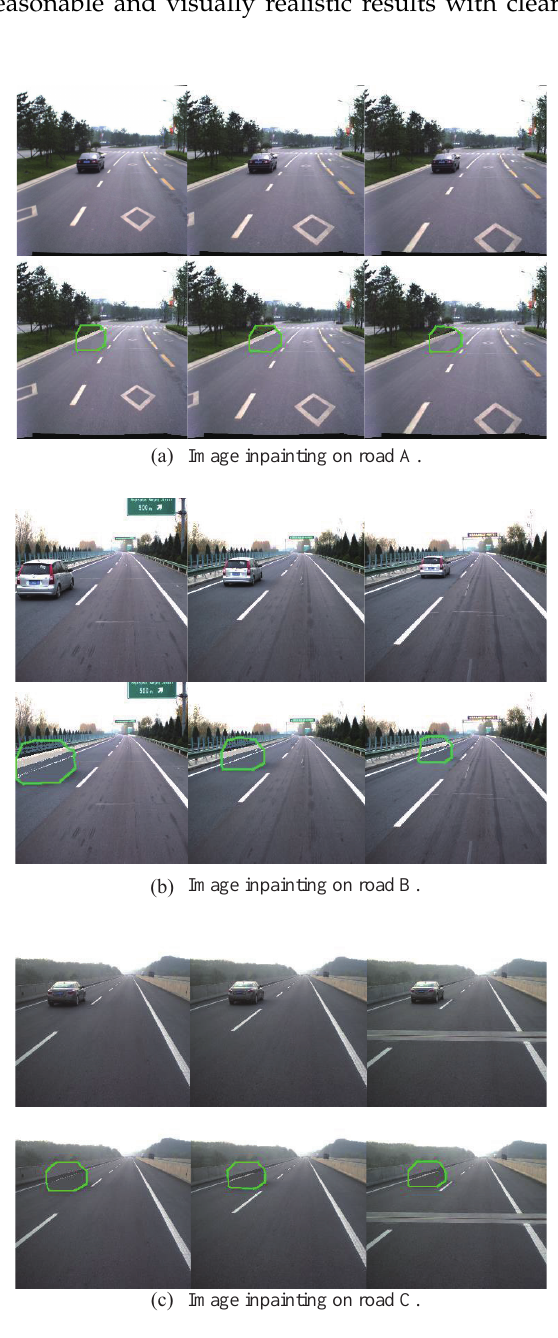
Figure 8. Qualitative results for image inpainting on